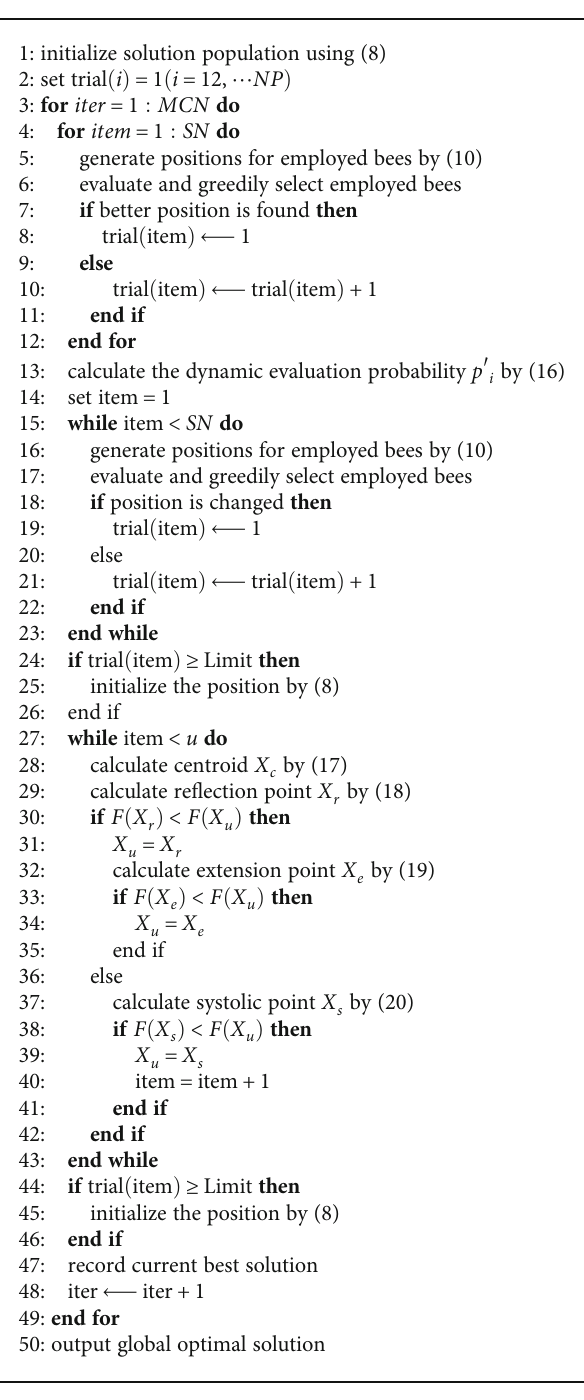
Algorithm 1: The I-ABC